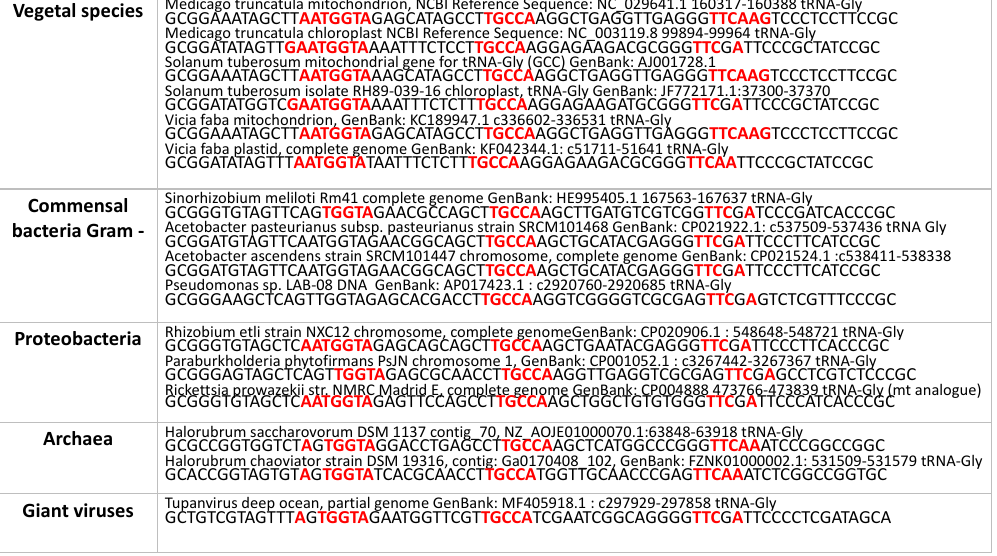
Table 1. ALPHA proximity. The more the molecules considered are essential for protein translation, the greater is their ALPHA pentameric proximity P 22 (calculated on the 22 pentamers of AL). Molecular family